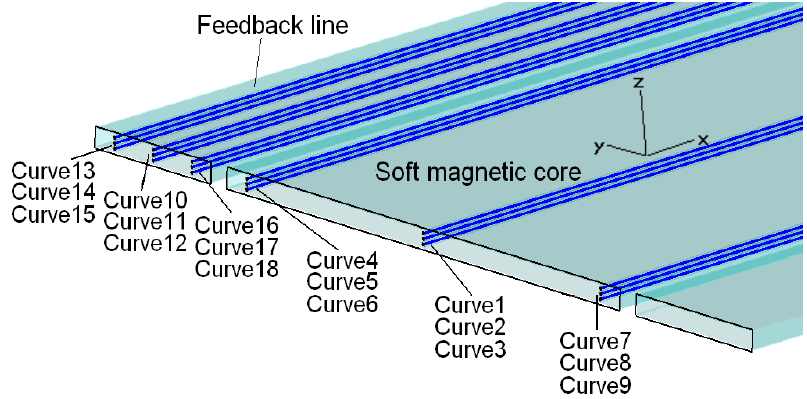
Figure 5. Tracking curves in the soft magnetic core and feedback line.